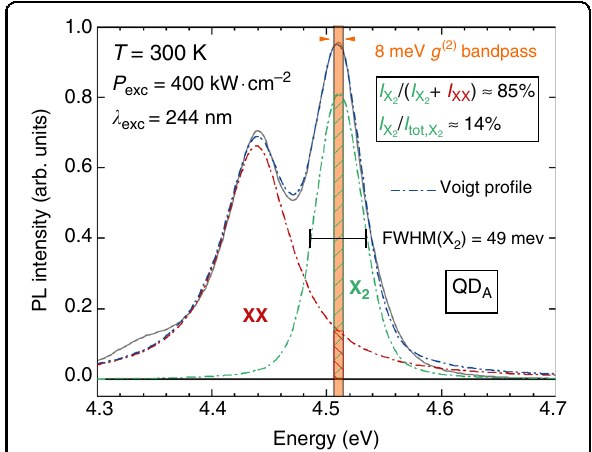
Fig. 6 Room temperature µ-PL spectrum recorded on QD A approximated by a two-peak function. The biexciton is fi tted with a Lorentzian (red dash-dotted line). X 2 is not fully Lorentzian and is best approximated by a Voigt function (green dash-dotted line), hinting at the underlying presence of X 1 whose impact remains however negligible. The resulting two-peak fi t is highlighted with a blue dash-dotted line. The detection window of the HBT setup is indicated along with the contribution of X 2 ( I X2 ) and XX ( I XX ) to the measured signal (hatched areas). I tot,X2 stands for the integrated intensity of the X 2 line. The FWHM of X 2 is